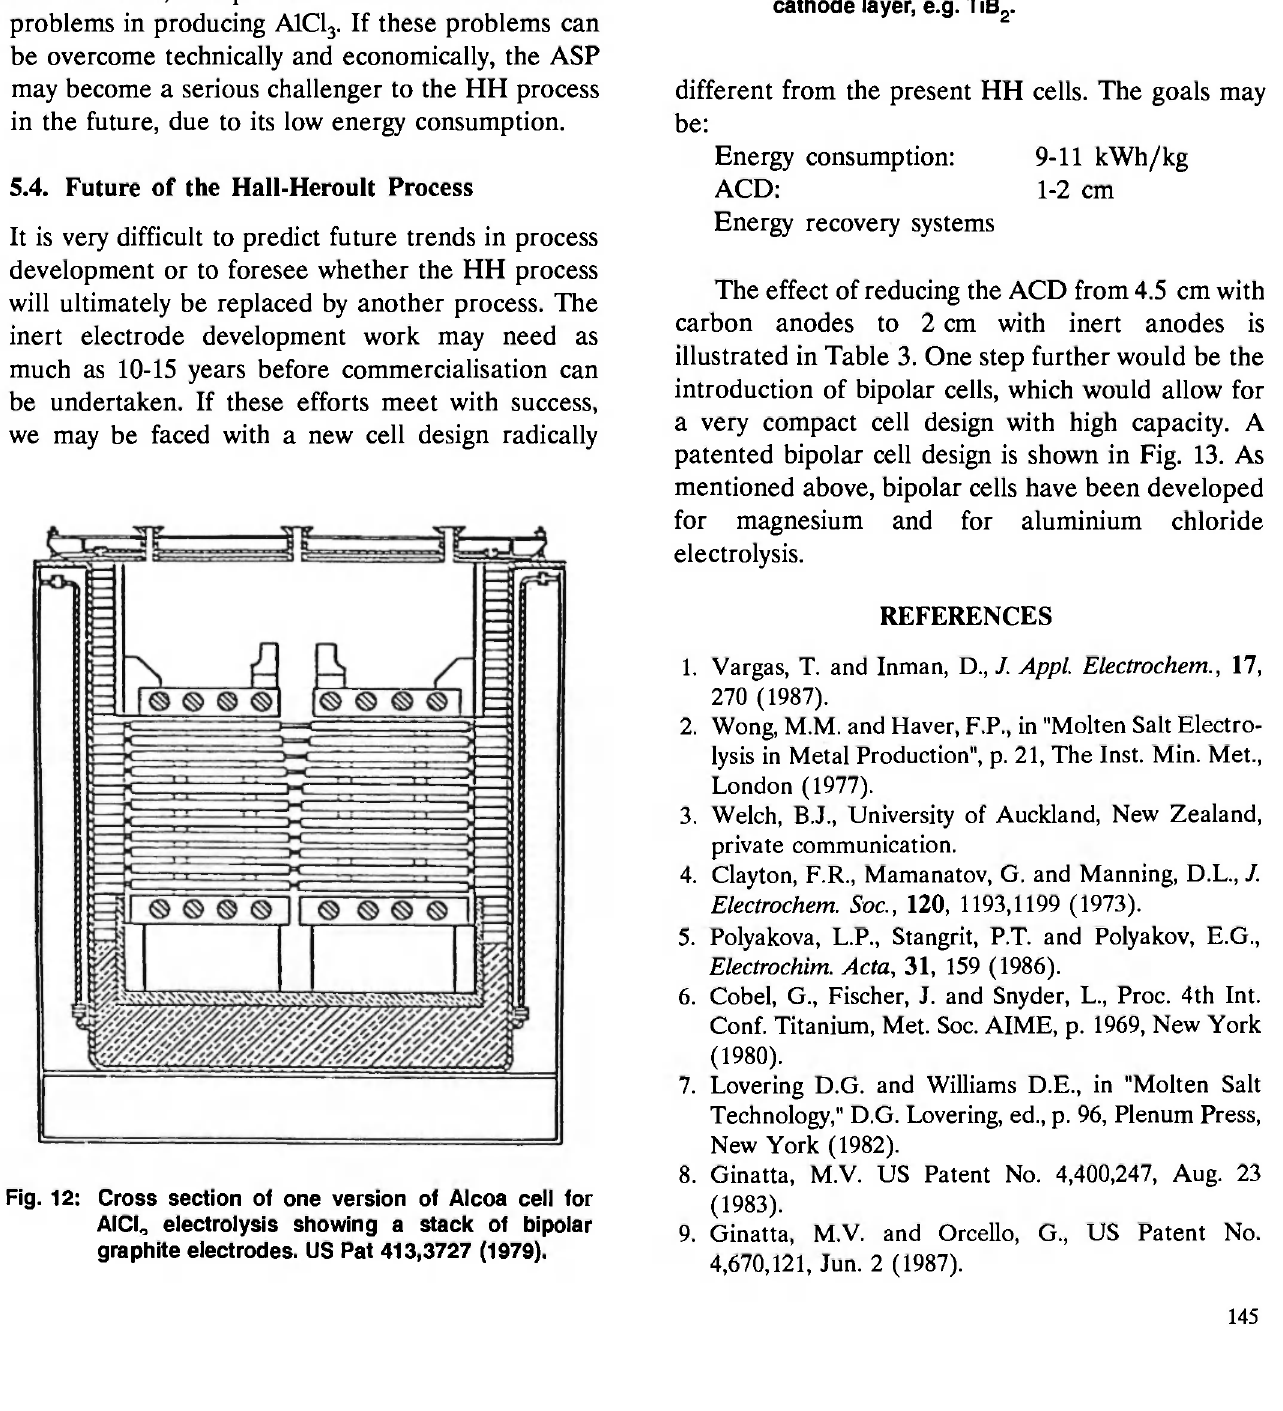
Fig. 13: Bipolar cell for aluminium electrolysis due to Alusuisse /23/. The vertical bipolar electrodes consist of: 3 - an anode layer, ceramic oxide, 4 - an intermediate conducting layer, and 5 - a cathode layer, e.g. TiB 2